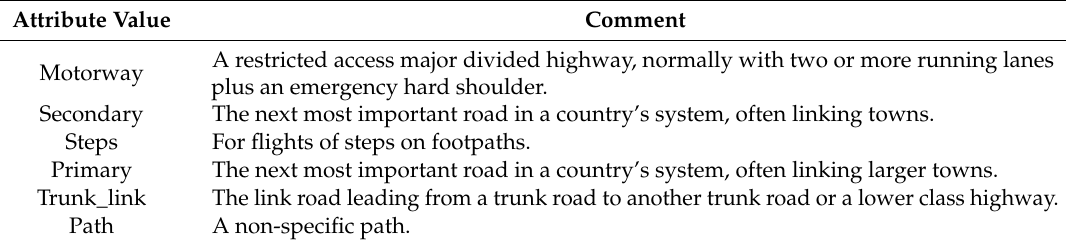
Table 1. Attribute values for the Fclass